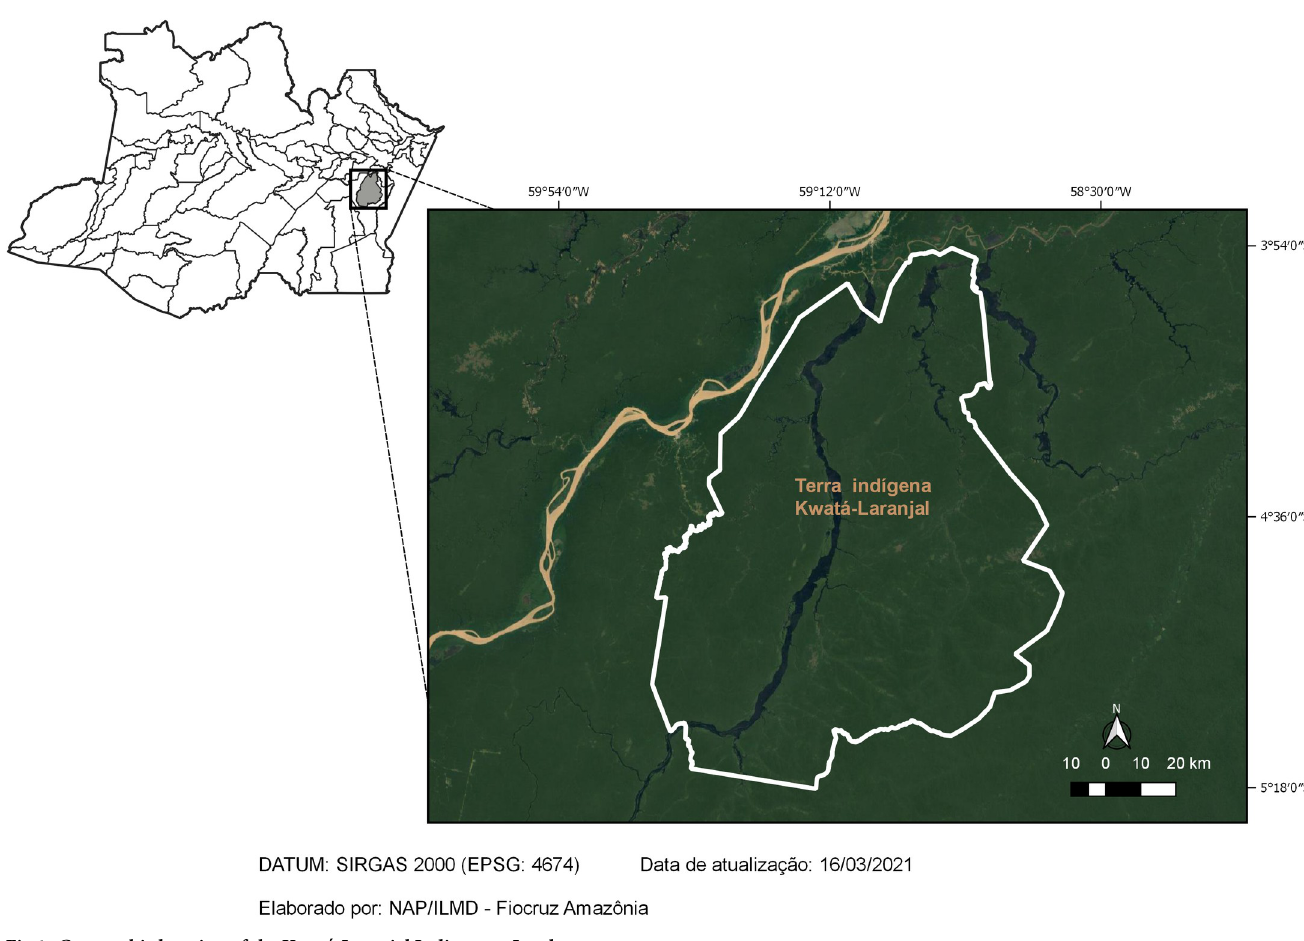
Fig 1. Geographic location of the Kwata´-Laranjal Indigenous